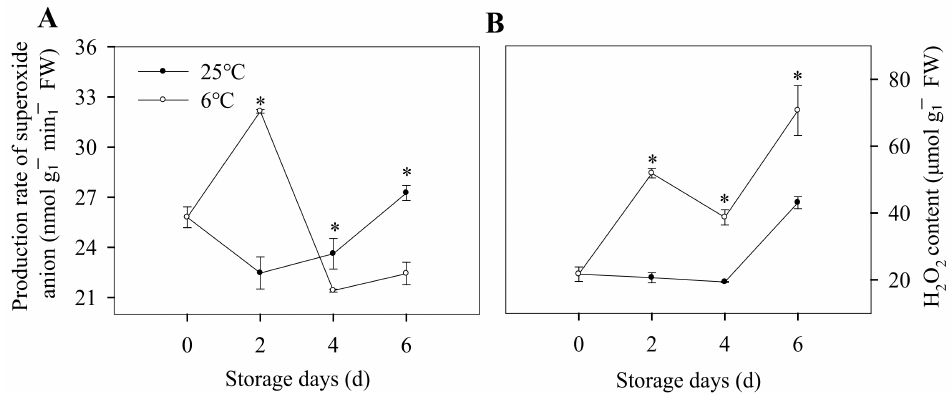
Figure 2. Changes in oxidative stress of banana fruit during storage at 6 ◦ C and 25 ◦ C. Production rate of superoxide anion ( A ) and H 2 O 2 content ( B ) of banana peels during storage. Each data point represents a mean ± standard error ( n = 3). ‘*’ means a significant difference between control and experimental fruit at the 5%